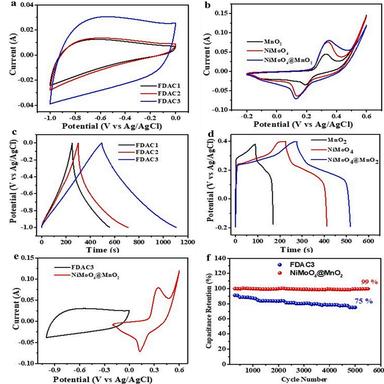
Electrochemical performance of the all as-prepared electrode materials in 3 M KOH electrolyte. CV curves of the as-prepared working electrodes at constant scan rates of 20 mV/s (a and b), GCD curves at constant current densities of 5 and 4 mA/cm2 , (c and d), CV curves of FDAC3 and NiMoO4@MnO2 at a constant scan rate of 20 mV/s (e) and the cycling stability of the two different electrodes at 60 mA/cm2 (f).